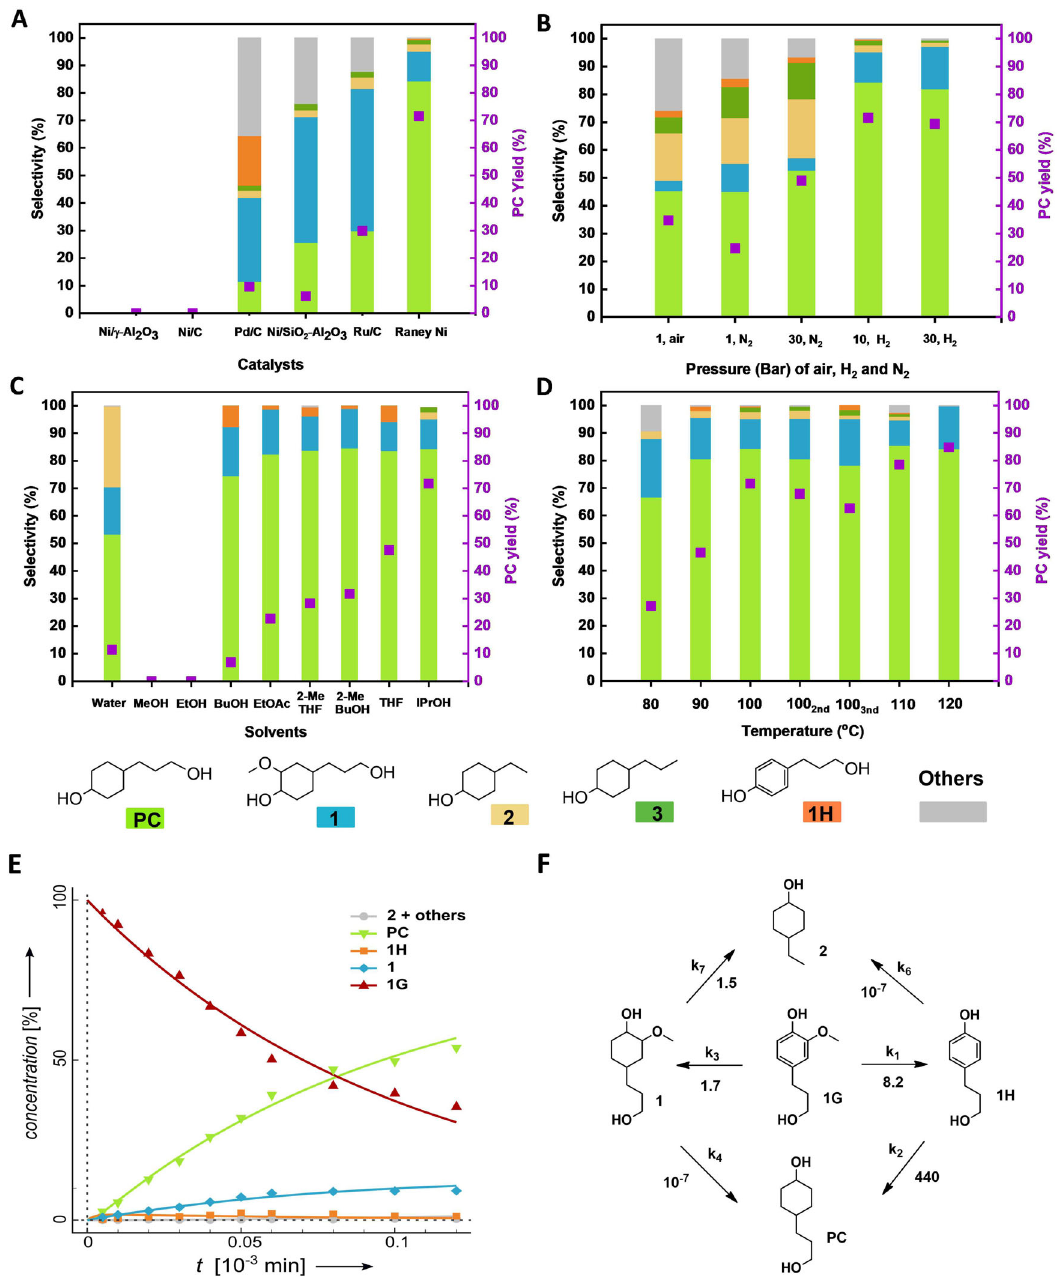
Fig. 2 Establishing optimal reaction conditions for the catalytic conversion of 1 G to PC. Standard reaction conditions unless otherwise speci fi ed: 1 G (1.1 mmol, 0.200 g), 1 g wet Raney Ni, 100 °C, 2 h, 10 bar H 2, 15 mL solvent, 10 mg dodecane. Screening of A commercially available heterogeneous metal Table S1 – S4; Conversion and yield values were determined by GC-FID using calibration curves and internal standard; E Proposed reaction network and calculated apparent rate constants from data fi tting, utilizing the DynaFit software (k app in 10 − 3 min − 1 ); F Fitting of the experimental data for catalytic conversion of 1 G, 1 , 1H, and PC over wet Raney Ni catalyst. Reaction conditions: 1.1 mmol substrates, 0.500 g wet Raney Ni, 100 °C, 20 bar H 2 , 20 mL isopropanol, 20 mg dodecane as internal standard. Data were presented in detail in Supplementary Tables S6 –